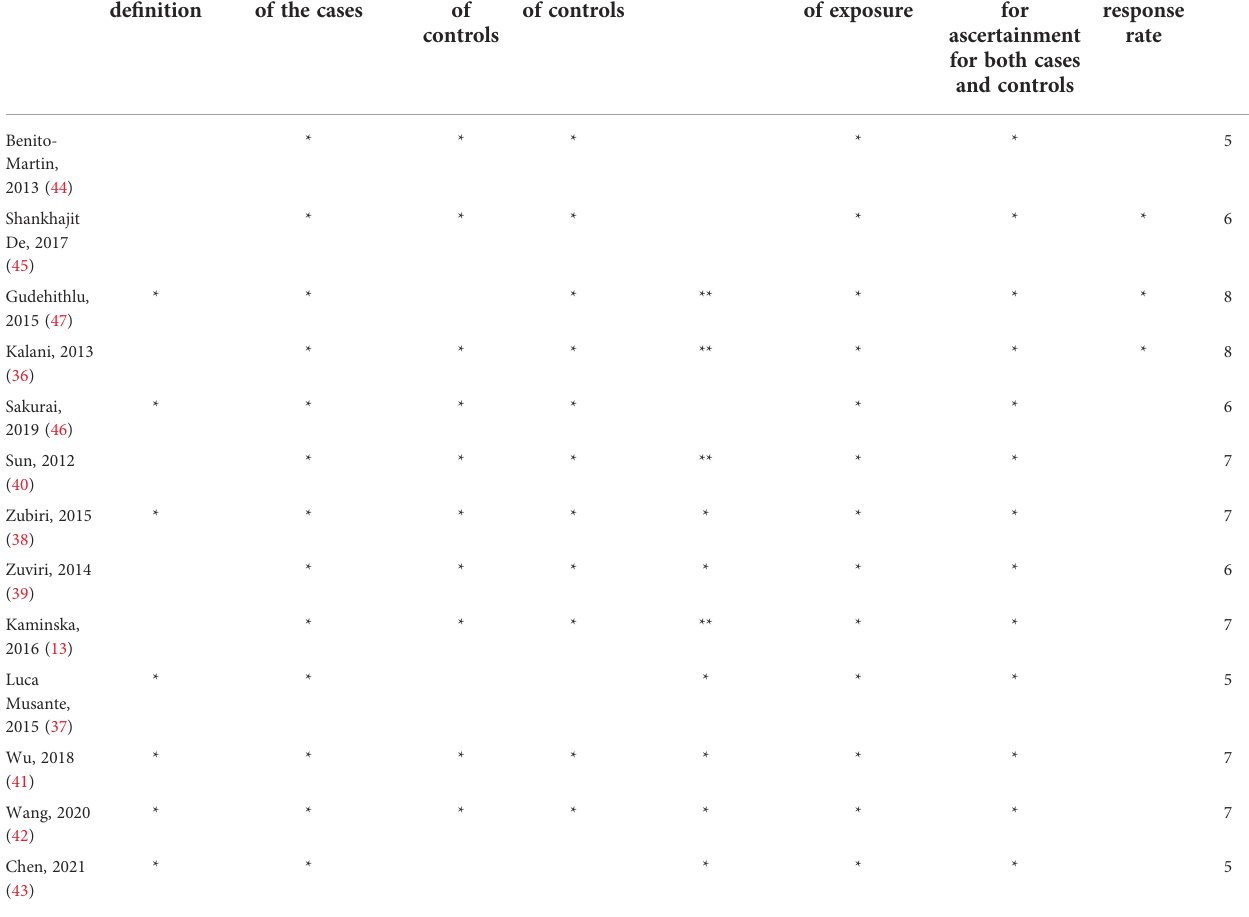
TABLE 2 Quality assessment under Newcastle-Ottawa